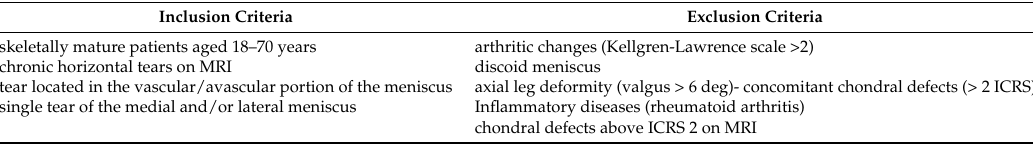
Table 5. Inclusion and exclusion